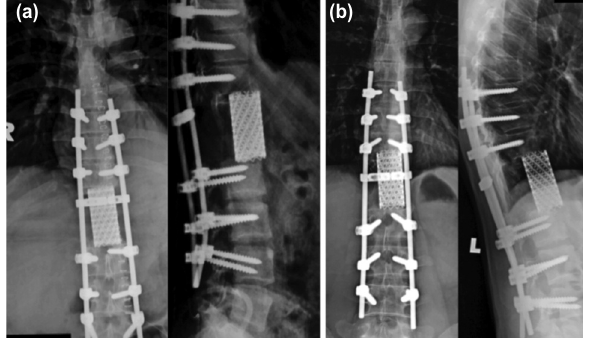
(a) Immediate post-operative radiograph. (b) One year Fig. 2: post-operative radiograph showing no loosening of implants.